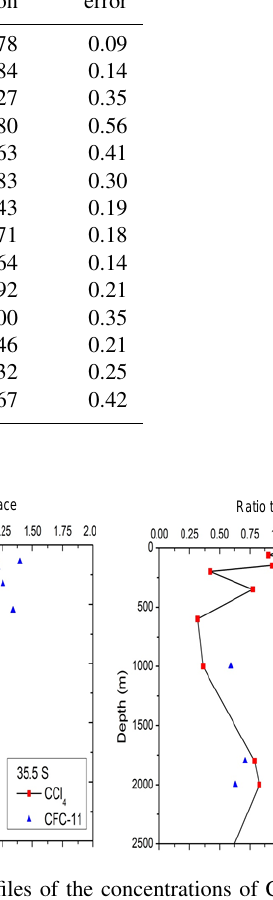
Table 3. Corrected saturation anomalies for 10 ◦ latitude-bins. Positive values not included (see text and Fig. 5). Bin Assigned mean